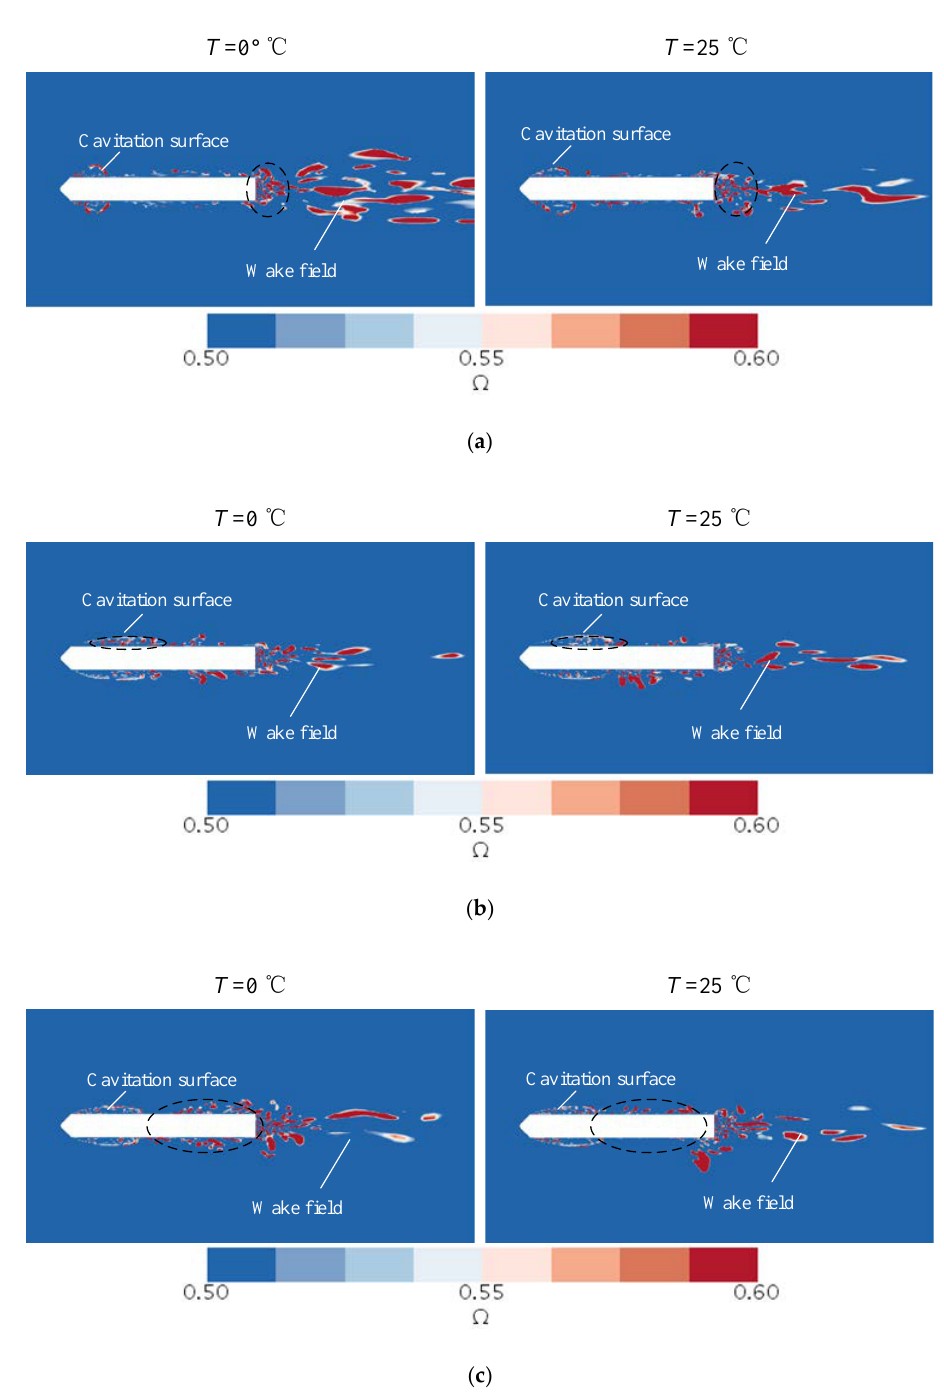
Figure 11. Comparison of two-dimensional natural cavitation vortex structure based on Ω method at 0 ◦ C and 25 ◦ C. ( a ) Comparison of two-dimensional vortex structures during cavity development. ( b ) Comparison of two-dimensional vortex structures during cavity stabilization. ( c ) Comparison of two-dimensional vortex structures during cavity